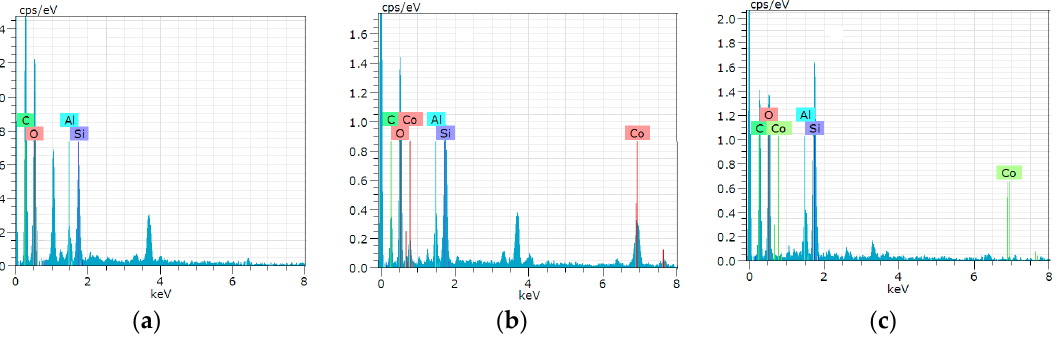
Figure 19. Energy ‐ Dispersive X ‐ ray (EDX) spectra for: ( a ) LMT; ( b ) Co(II) ‐ loaded LMT; and ( c ) Figure 19. Energy-Dispersive X-ray (EDX) spectra for: ( a ) LMT; ( b ) Co(II)-loaded LMT; and recovered LMT. ( c ) recovered LMT.